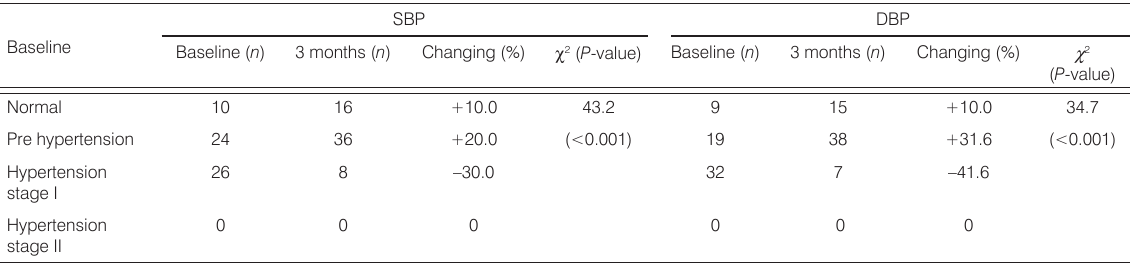
Table 4. The comparison of number of type BP baseline and 3 months data in the intervention group ( n = 60).